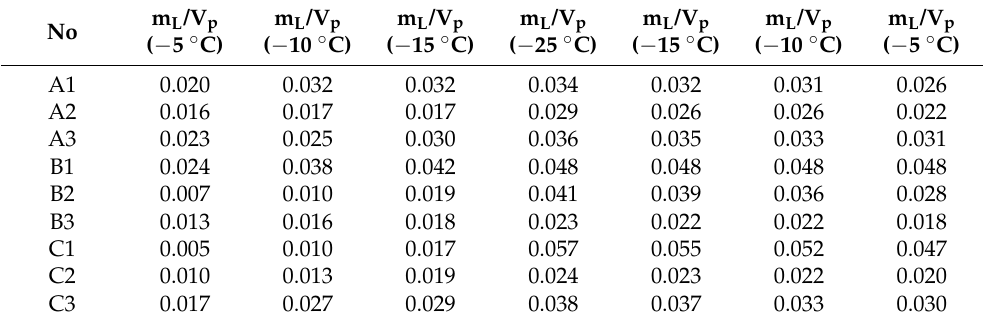
Table 1. List of m L /V p ratios determined by the DAVS method during freezing and thawing process.